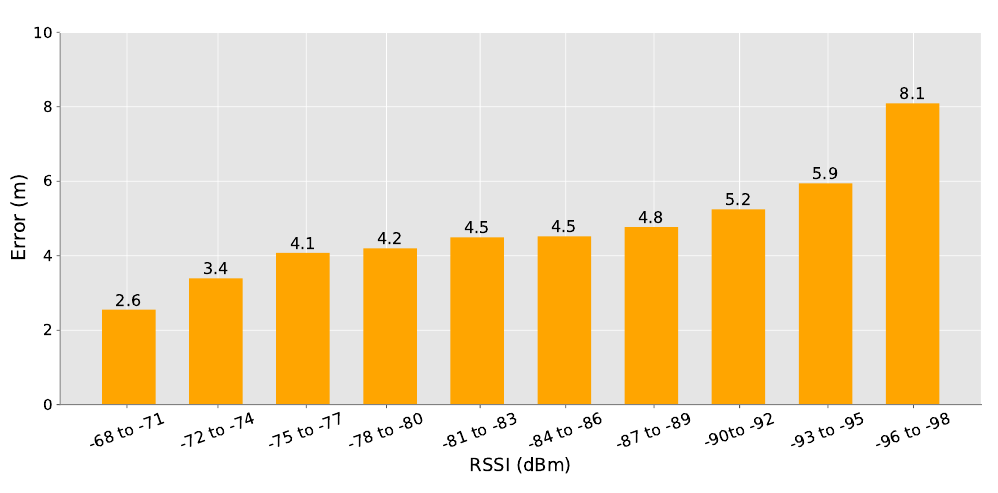
Figure 9. Positioning error by average RSSI. The farther the anchor nodes, the higher the positioning error. Even slightly farther anchor nodes can increase the positioning error by almost 1 m.